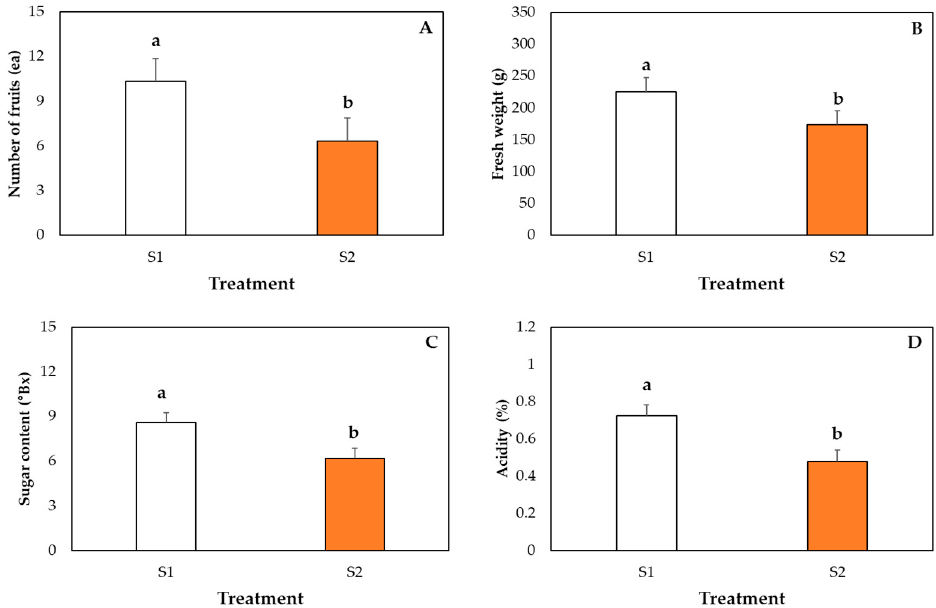
Figure 7. Effect of shade screen on number of fruits ( A ), fruit weight ( B ), sugar content ( C ) and acidity ( D ) of paprika in a greenhouse. S1 and S2 indicate that plants were treated by single shade screen and double shade screens, respectively. Lines above bar represent the standard deviation of the mean ( n = 10). Means above each bar followed by the same letters are not significantly different by Duncan’s multiple range test (DMRT) at p ≤ 0.05.